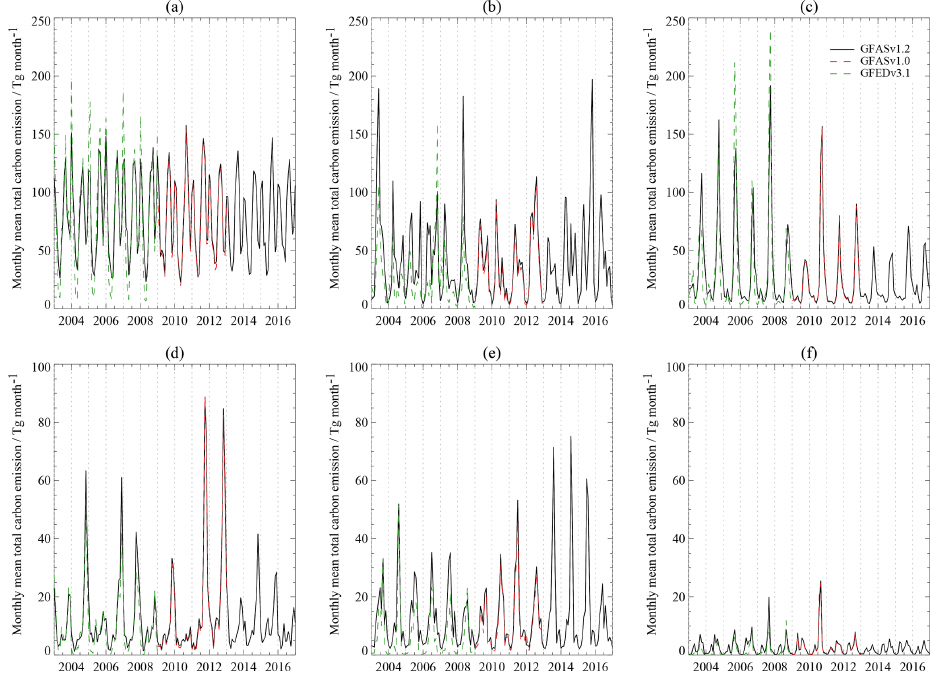
Figure 4. Time series of monthly total carbon wildfire emissions in Tgmonth − 1 from GFASv1.2 (2003–2016, black solid line), GFASv1.0 (2009–2012, red dashed line) and GFEDv3.1 (2003–2008, green dashed line) for geographical domains covering (a) Africa, (b) Asia, (c) South America, (d) Australia, (e) North America and (f) Europe.